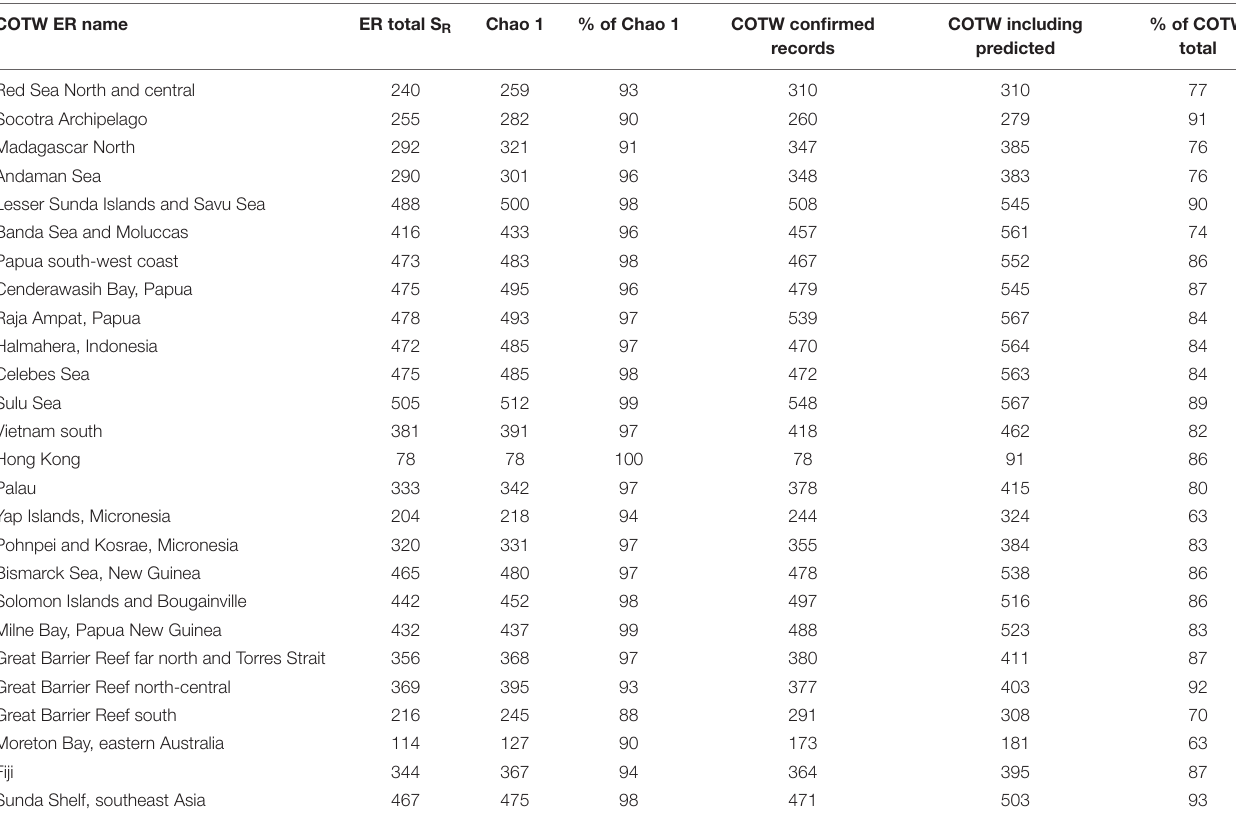
TABLE 3 | Comparisons between various estimates of regional richness for IWP reef-building corals, for the two depth ranges combined. COTW ER